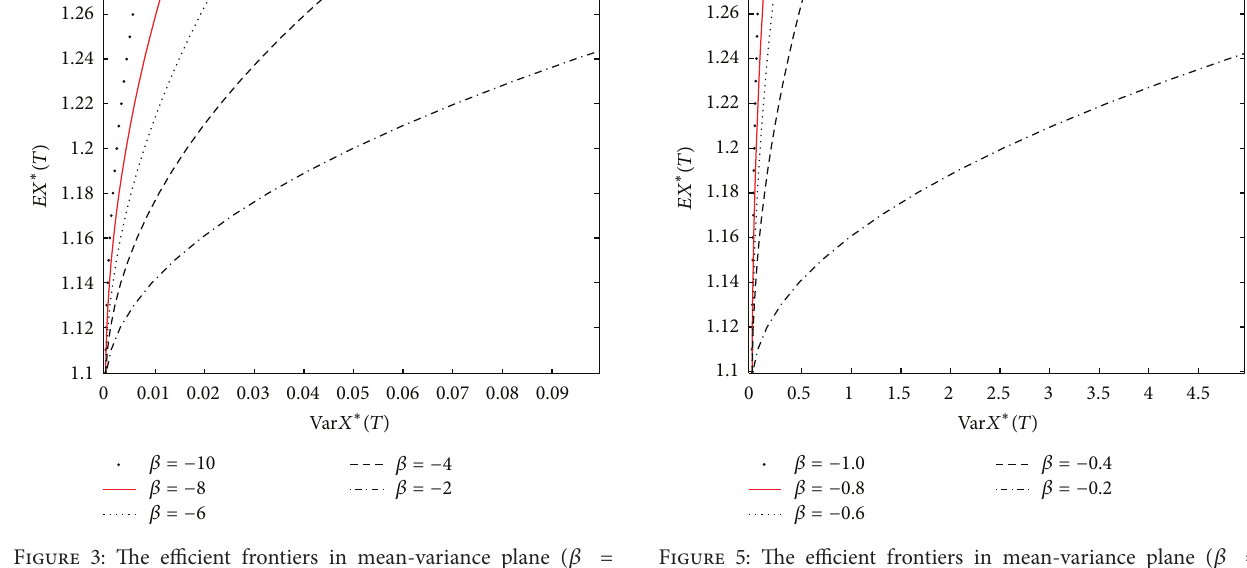
Figure 3: The efficient frontiers in mean-variance plane ( 𝛽 = −10, −8,...,−2 ).